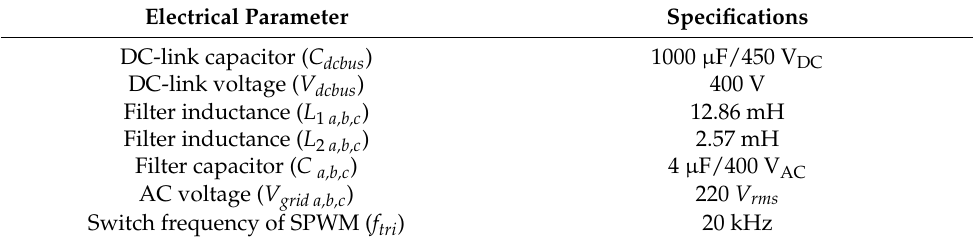
Table 2. Electrical parameter of inverter.